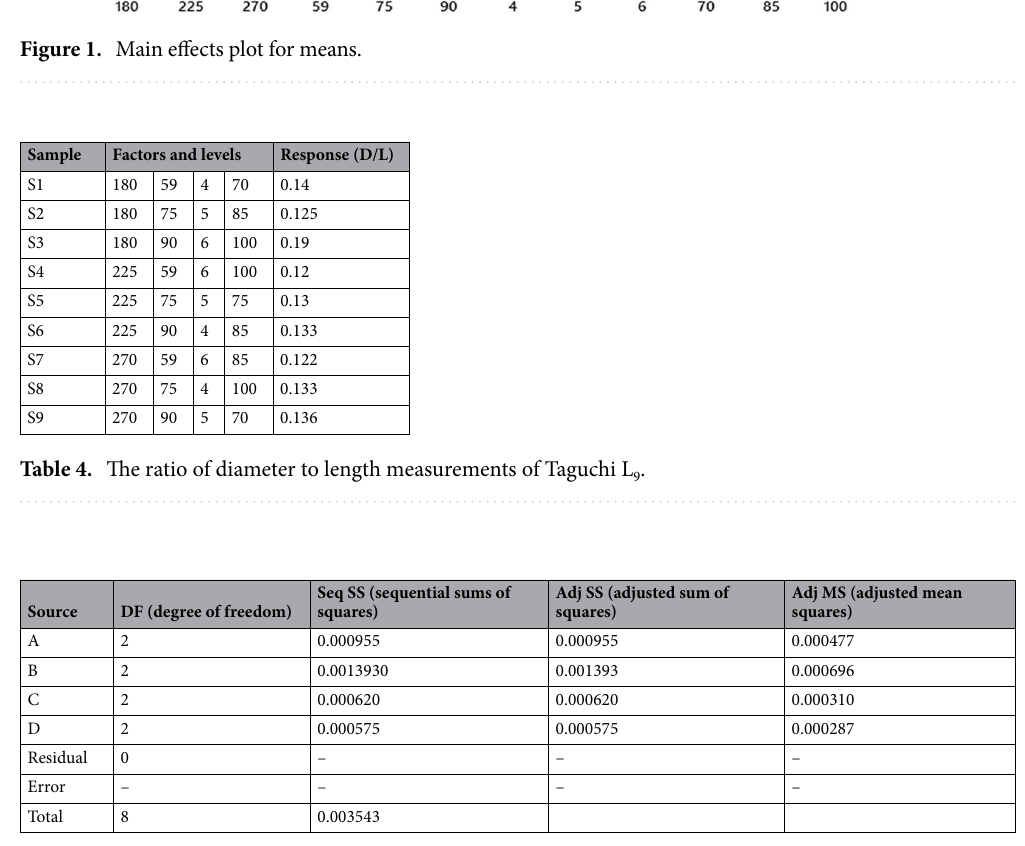
Table 5. Analysis of variance for